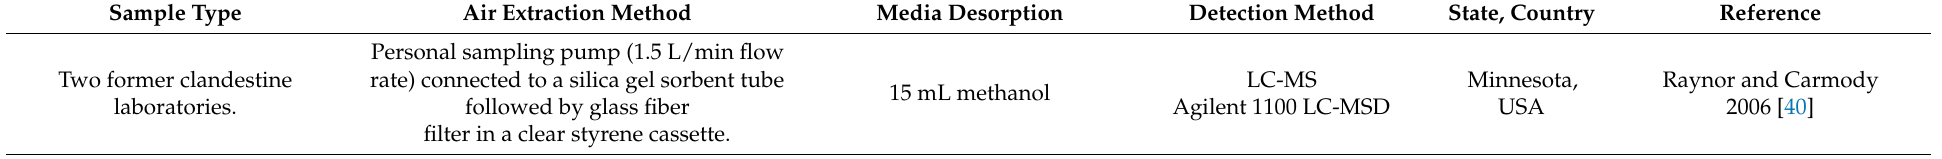
Table 2. Summary of indoor air studies identifying the sample type, indoor air extraction methods, desorption methods, and detection